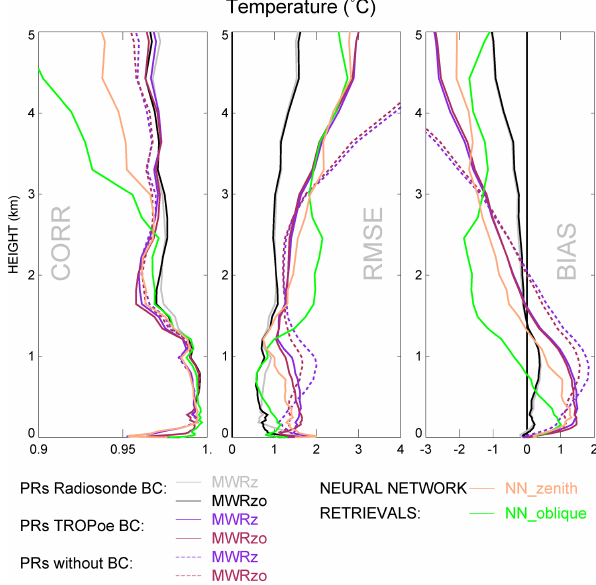
Figure A1. Pearson correlation, RMSE, and mean bias for tem- perature profiles for MWRz in gray (and purple) and MWRzo in black (and maroon) when the radiosonde BC (and the TROPoe BC) method is applied. TROPoe temperature retrievals without any bias correction are shown for MWRz in dashed purple and for MWRzo in dashed maroon. Included in this figure are the NN temperature profiles, from the zenith scan (in beige) and from the averaged oblique scans (in